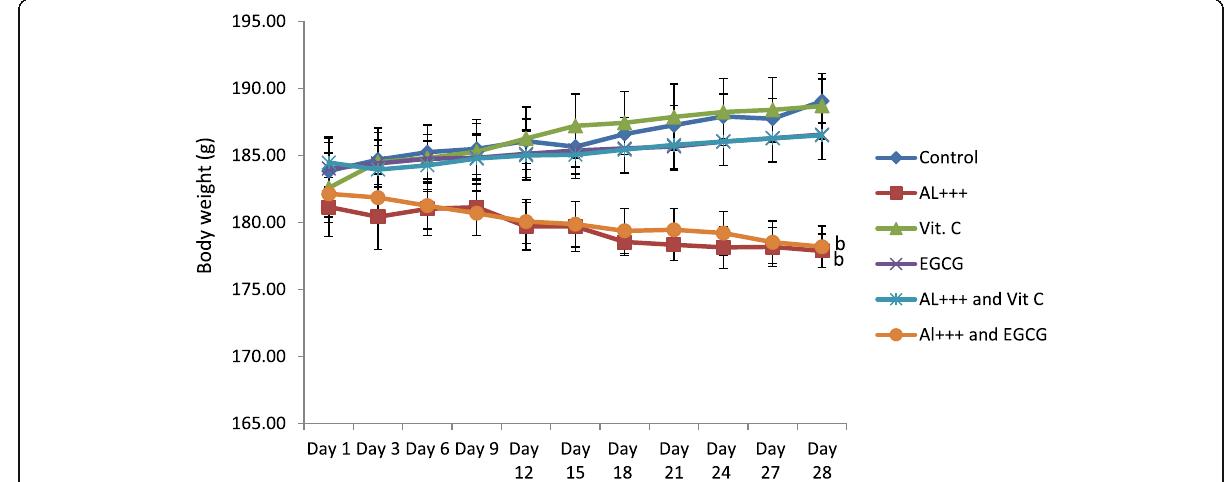
Fig. 1 Effect of aluminum, vitamin C, EGCG, aluminum + vitamin C, and aluminum + EGCG on regular body weight growth of animals. Values are expressed as mean ± SEM ( n = 6). b P < 0.01 compared with control (one-way ANOVA followed by Tukey ’ s post-hoc